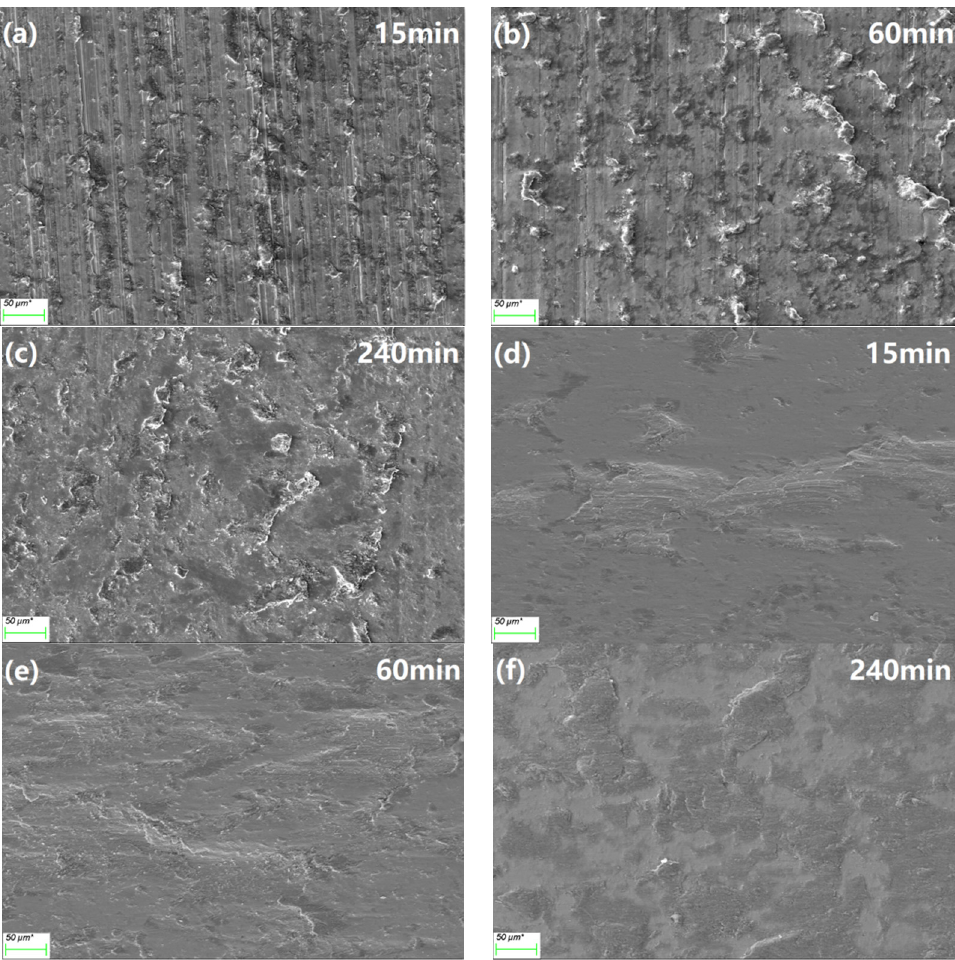
Figure 5. Surface morphology of GCr15 disc or flat after rotary ( a – c ) and reciprocating sliding ( d – f ) for different sliding durations.